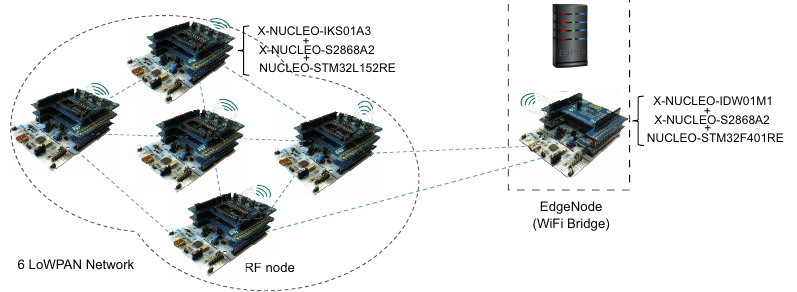
Figure 6. Hardware components of considered 6LoWPAN